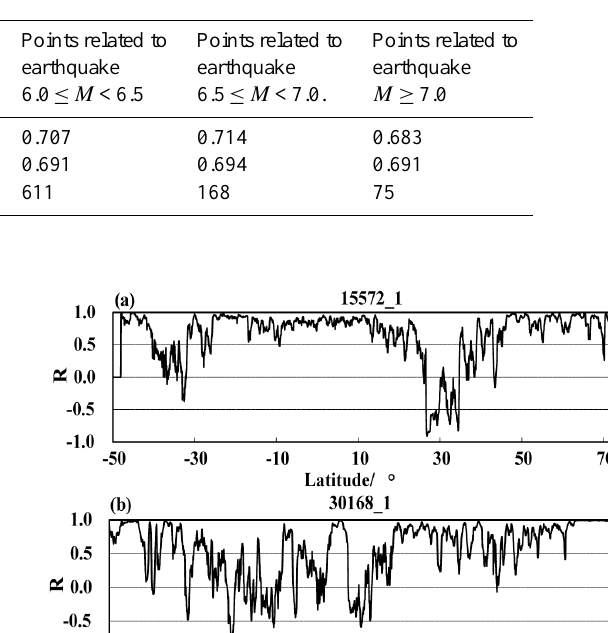
Table 1. The statistical results of R with all observation points and of those related to earthquakes at different magnitude levels.